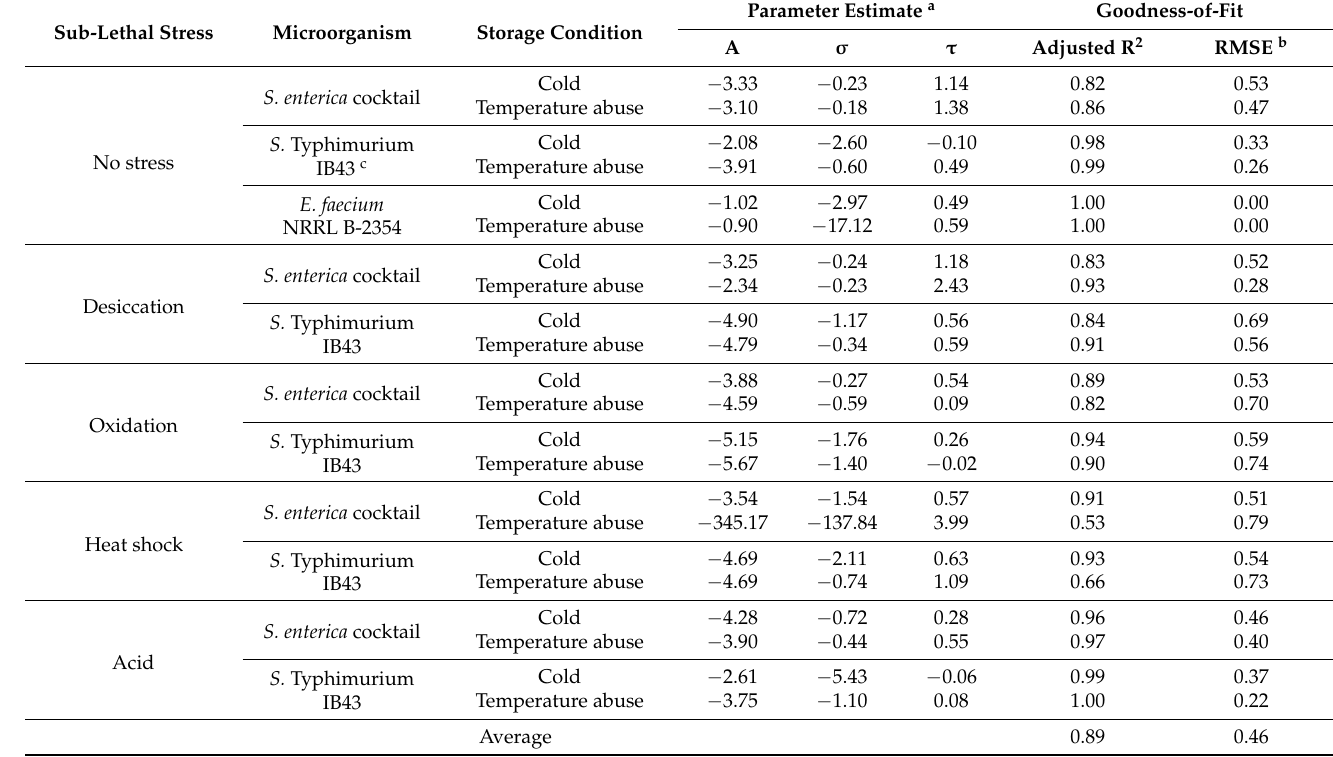
the maximum absolute death rate and their survival curves had greater differences in the upper and lower asymptotes. Table 2. Parameter estimates and goodness-of-fit of the log-logistic model for the persistence of S. enterica and E. faecium NRRL B-2354 on baby spinach under cold and temperature abuse conditions with or without prior exposure to sub-lethal stresses.